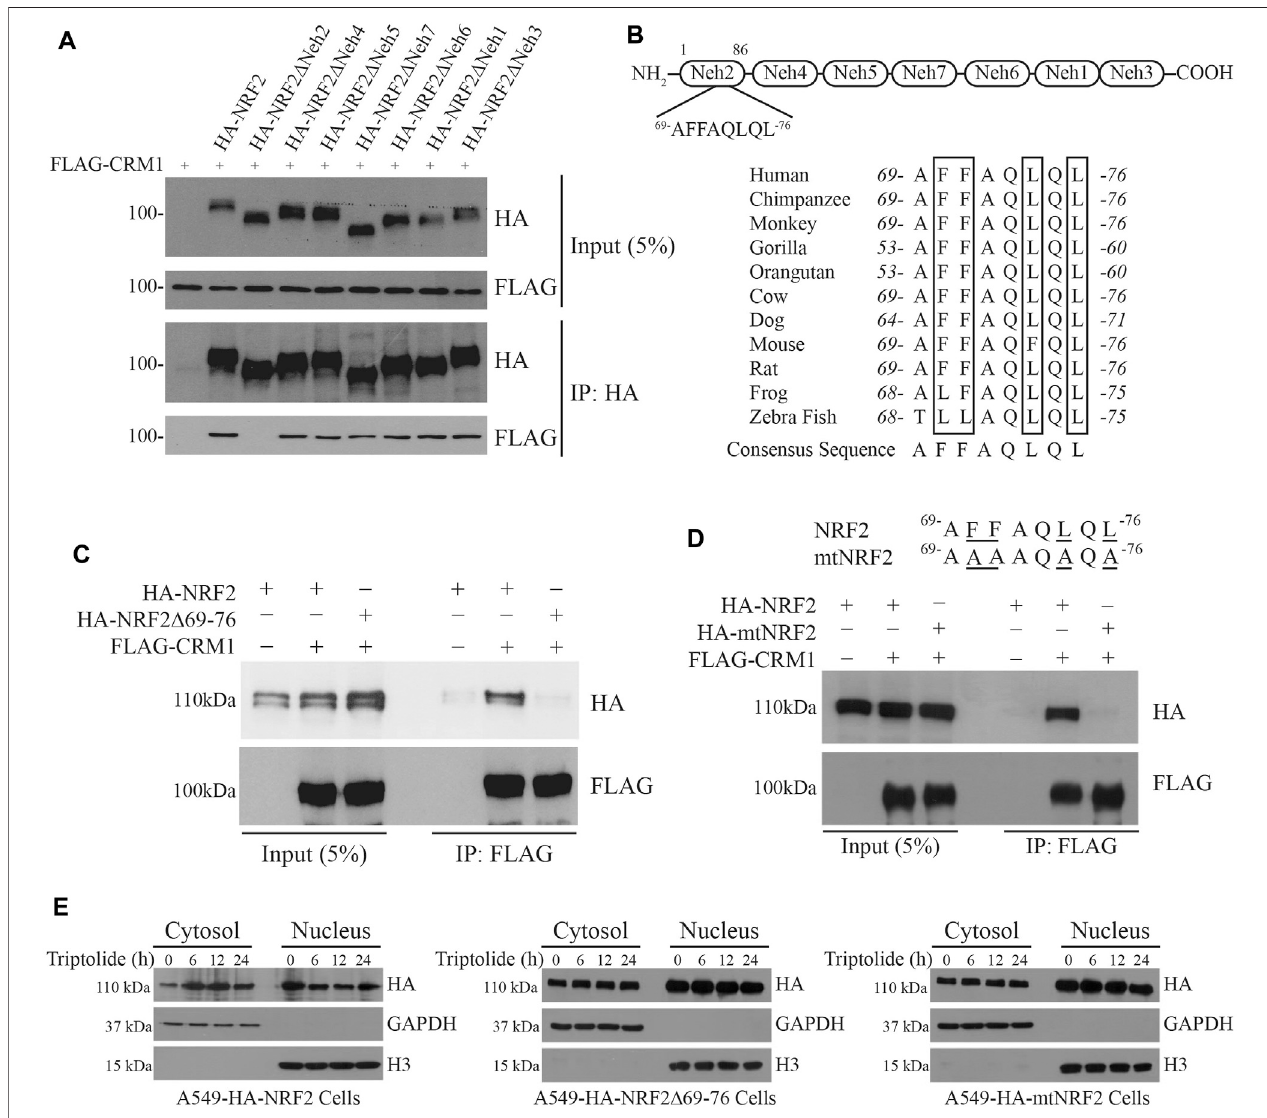
FIGURE 3 | Identi fi cation of a novel nuclear export signal (NES) in the Neh2 domain. (A) The Neh2 domain is responsible for binding to CRM1. pcDNA3-FLAG- CRM1plasmid(1 μ g)wascotransfectedwithpcDNA3-HA-NRF2(1 μ g)orpcDNA3-HA-NRF2plasmidsdeletedwiththeindividualNehdomains(1 μ g)in293Tcells.The celllysateswerecollectedandimmunoprecipitatedwithanti-HAbeads.Afterimmunoprecipitation,WesternblotanalysiswasperformedusingHA-HRPandFLAG-HRP antibodies. (B) Domain architecture of the Neh domains in NRF2 (Upper Panel) and the existence of the NES-like sequence in the Neh2 domain, which is highly preserved across the species (Lower Panel). (C) NRF2 deleted with the NES-like sequence in the Neh2 domain fails to bind to CRM1. pcDNA3-FLAG-CRM1 plasmid (1 μ g) was cotransfected with pcDNA3-HA-NRF2 (1 μ g) or pcDNA3-NRF2 Δ 69-76 deletion mutant (1 μ g) in 293T cells for 24 h. The cells lysates were collected and immunoprecipitated with anti-FLAG beads. After immunoprecipitation, Western blot analysis was performed using FLAG-HRP and HA-HRP antibodies. (D) NRF2 mutatedintheNES-likesequenceintheNeh2domain(mtNRF2)failstobindtoCRM1.pcDNA3-FLAG-CRM1plasmid(1 μ g)wascotransfectedwithpcDNA3-HA-NRF2 (1 μ g) or pcDNA3-mtNRF2 (1 μ g) plasmids in 293T cells for 24 h. The cell lysates were collected and immunoprecipitated with anti-FLAG beads. After immunoprecipitation, Western blot analysis was performed using FLAG-HRP and HA-HRP antibodies. (E) Triptolide promotes the nuclear exclusion of HA-NRF2, but not that of NRF2 Δ 69-76 or HA-mtNRF2. StableA549-HA-NRF2, A549-HA-NRF2 Δ 69-76 and A549-HA-mutNRF2 cells were seeded in 100 mm culture plates (2 × 10 6 cells), and they were exposed to triptolide (20 nM) for various amounts of time. The cytosol and the nucleus were separated, and Western blot analysis was performed against HA. GAPDH and H3 were used as markers for the cytosol and the nucleus, respectively.